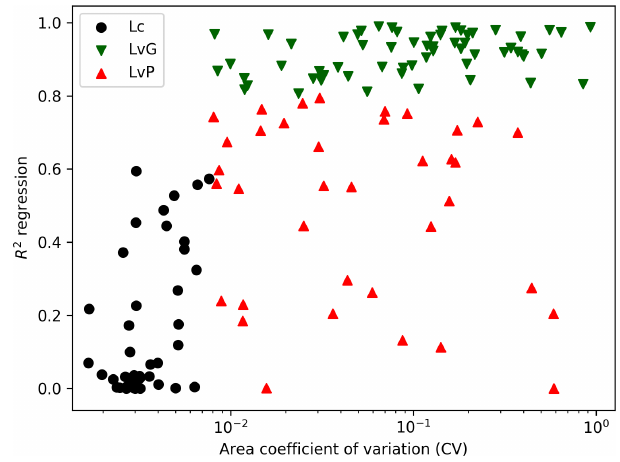
Figure 5. Illustration of the division of the lakes into lakes with a constant area (Lc) and a variable area with a good performance (LvG) and with a poor performance (LvP), based on the R 2 and CV